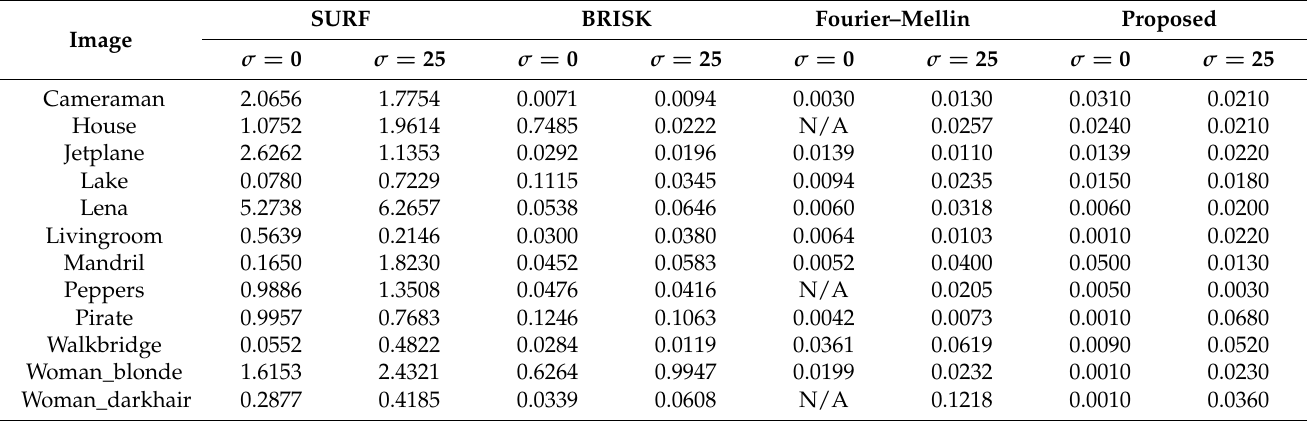
Table 1. Comparison of fixed rotation angle estimation errors; the rotation angle is 60 ◦ (degrees).